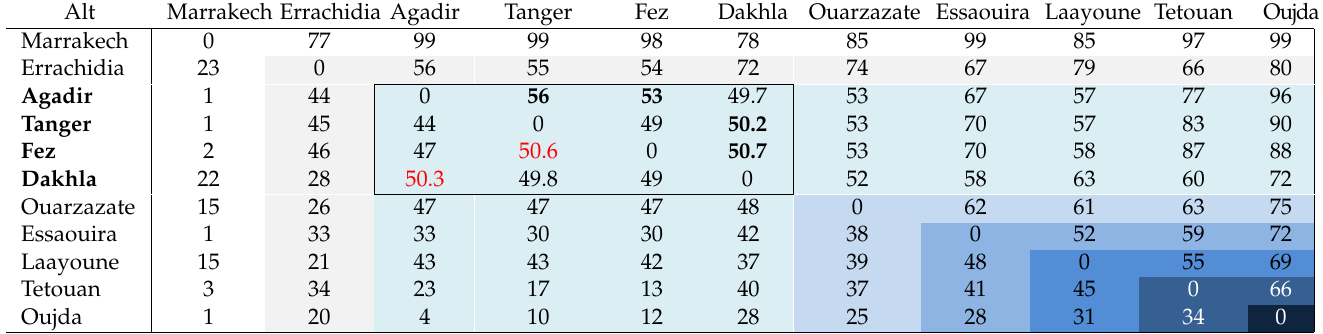
Table 5. Pairwise winning indices c ik for alternatives after second analysis. Partial ranking is formed based on c ik > 50%. Agadir, Tanger, Fez, and Dakhla share ranks 3–6. Cycles broken using the Ranked Pairs method are shown in